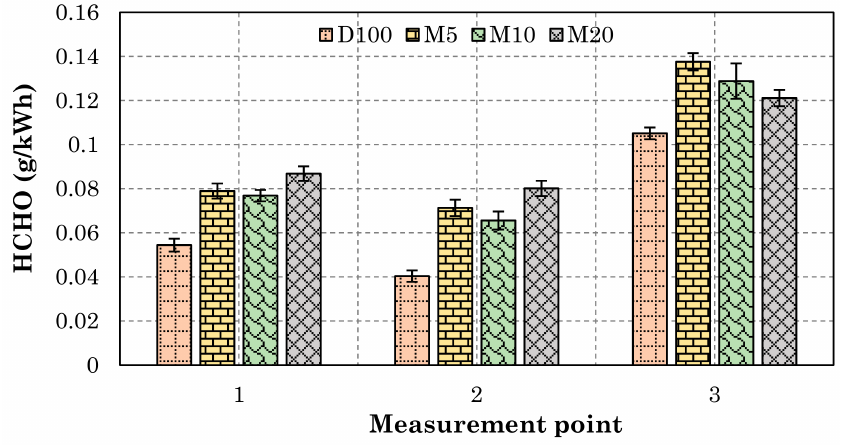
Figure 14. Specific HCHO emissions for all test fuels at all measurement points (error bars represent the standard